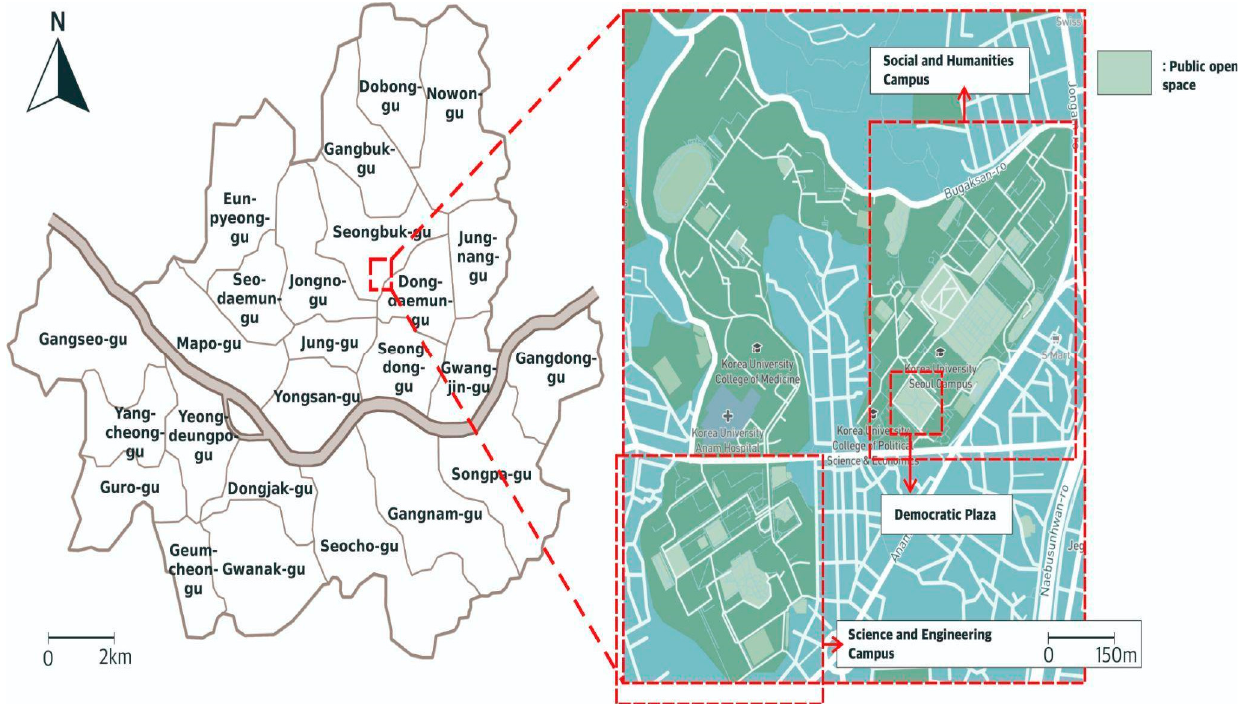
Figure 2. Map of the site (Korea University) and its location in Seoul Metropolitan City.